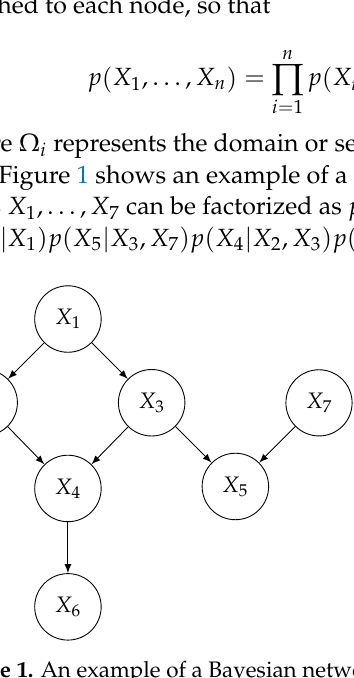
Figure 1. An example of a Bayesian